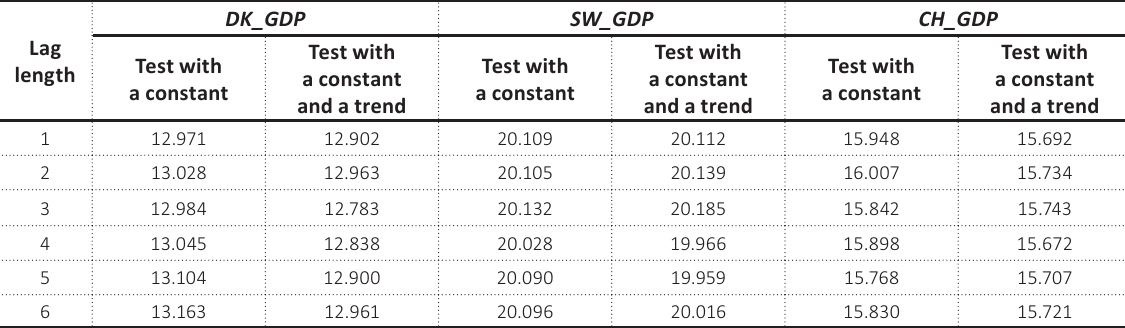
Table 3. Results of optimal lag via AIC for interest rates and GDP